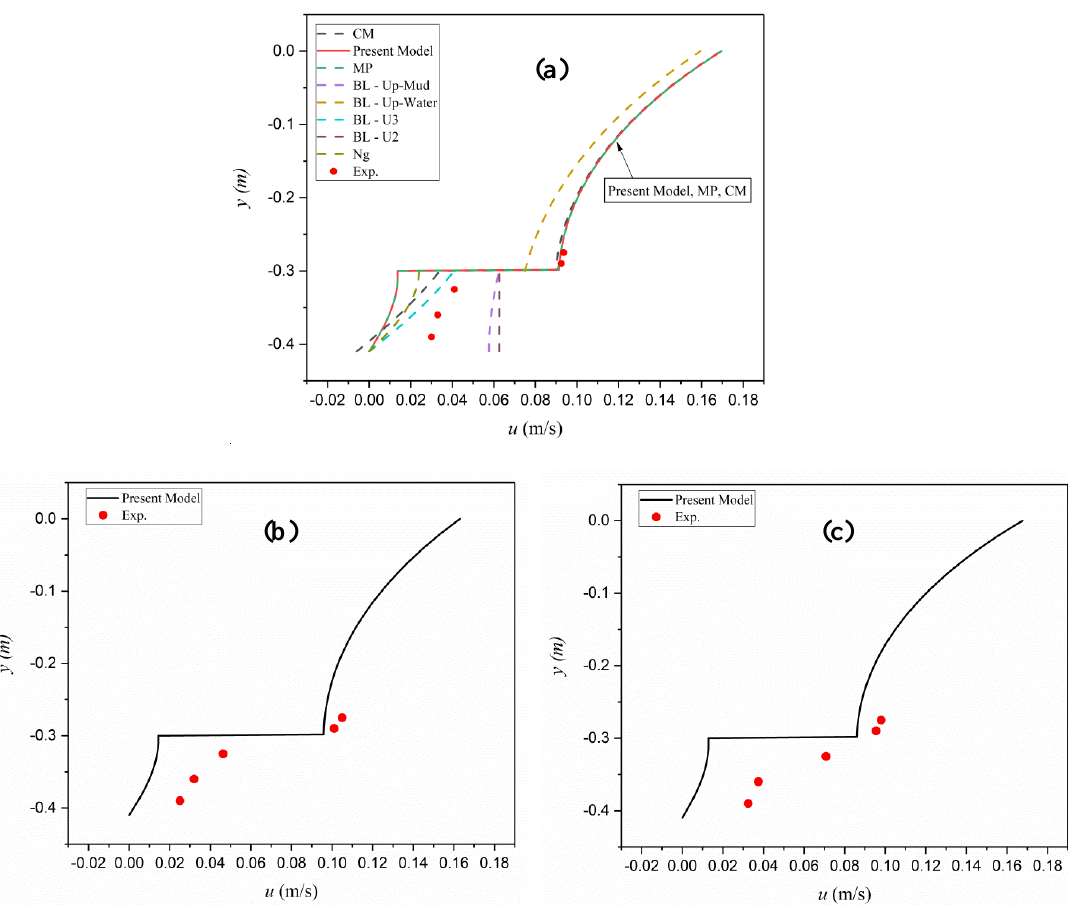
Figure 11. Comparison of velocity profiles of di ff erent analytical models and measurements, T = 1.1 s; H = 0.05 m; W = 160%; (a) no current, (b) U c = 0.07 m/s, (c) U c = −0.07 m/s.